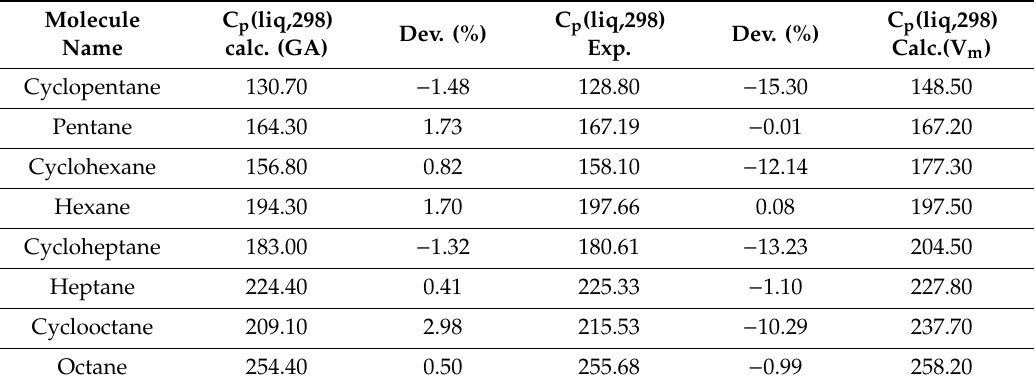
Table 5. Experimental C p (liq,298) data of four linear alkanes and four related cycloalkanes, compared with the prediction values calculated by the present GA and the V m [1] method (in J / mol / K).